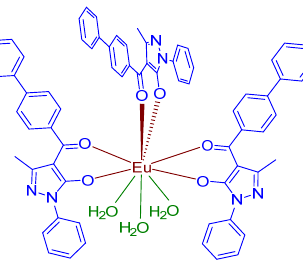
Figure 1. Neutral complex formed by the Eu (III) ion with 3-methyl-1-phenyl-4-(4-phenylbenzoyl)-